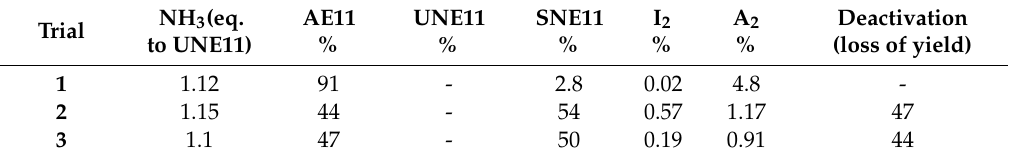
Table 6. Trial 1 : hydrogenation of UNE11 first cycle catalyst, Trial 2 : hydrogenation of UNE11 second cycle catalyst, catalyst washed with MeOH, Trial 3 : hydrogenation of UNE11 second cycle catalyst, catalyst washed with toluene. H 2 pressure: 60 bar. Trial 1 : hydrogenation of UNE11 with toluene, Trial 2 : hydrogenation of UNE11 with methyl-cyclohexane. AE11 : methyl-11-aminoundecanoate, UNE11 : (9 Z )-10-cyano-9-decenoate, SNE11 : methyl-10-cyanodecanoate. I 2 : secondary imine, A 2 : secondary amine, Dimer : dimer of AE11 (see Scheme 2 for molecular structure). Percentages of the reaction species were measured by GC–FID relative peak area.